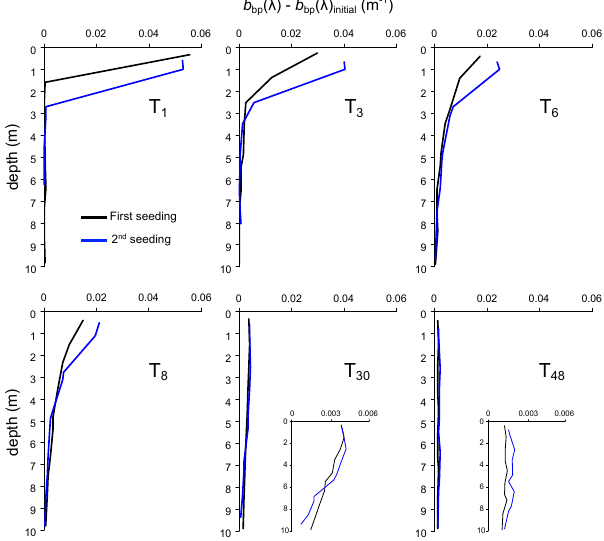
Fig. 4. Vertical profiles of 1b bp (λ) ( b bp (λ) − b bp (λ) initial in m − 1 ) at different times following both seedings. The wavelength used for this calculation differed between experiments (see Sect. 2.3). The insets (the T 30 and T 48 panels) show a close-up of the 0–0.006m − 1